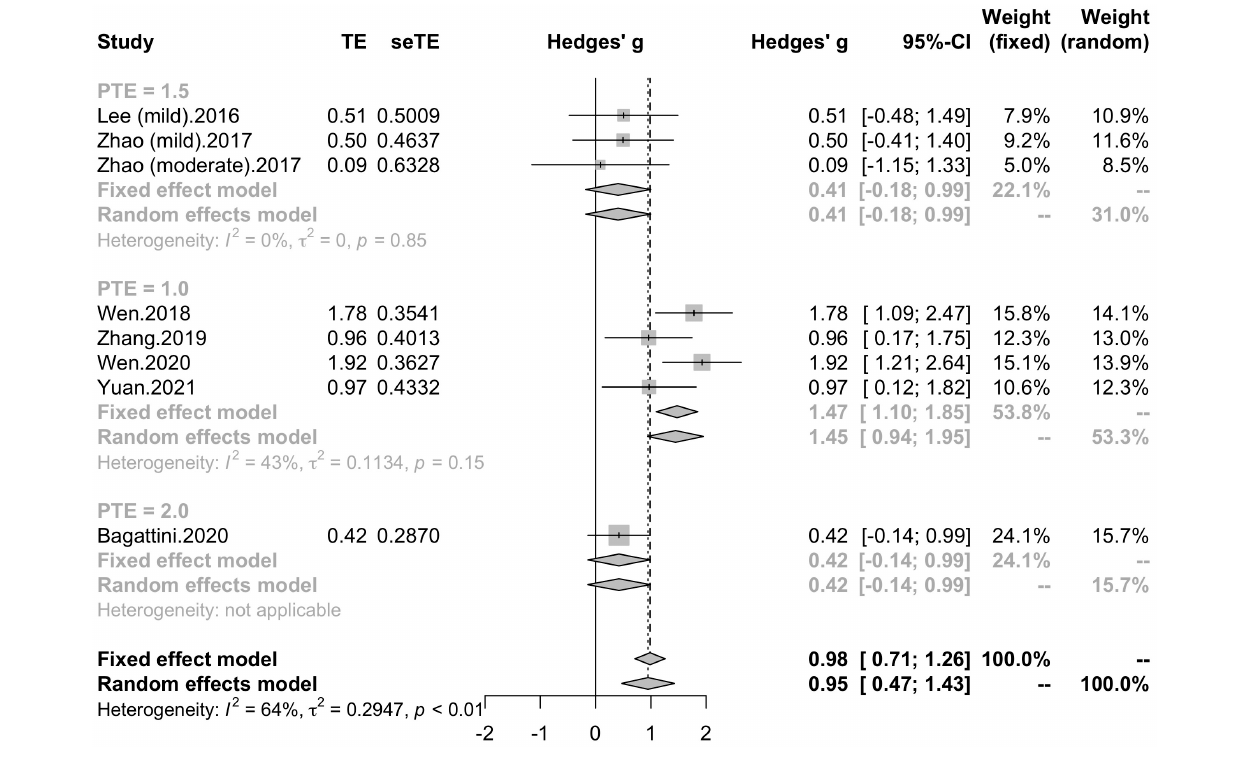
FIGURE 9 | Forest plot: mean differences in post-treatment effect subgroup with 95% CI. PTE, post-treatment